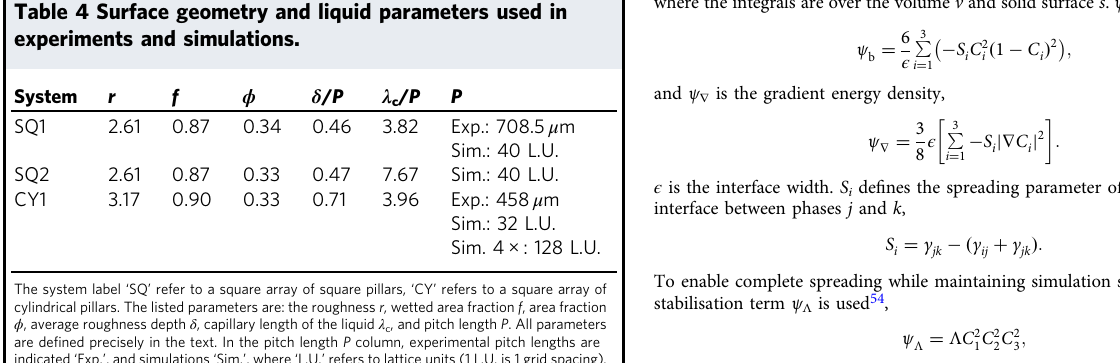
ϕ , average roughnessdepth δ , capillary length of the liquid λ c , and pitch length P . All parameters are de fi ned precisely in the text. In the pitch length P column, experimental pitch lengths are indicated ‘ Exp. ’ ,andsimulations ‘ Sim. ’ ,where ‘ L.U. ’